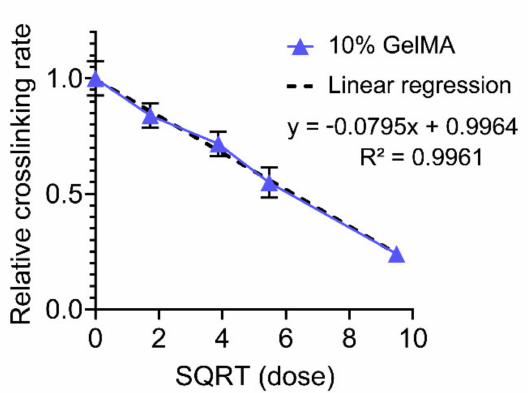
Figure 7. 10% GelMA crosslinking rate normalized to the control sample (no cefazolin) versus the square roots of cefazolin doses. Linear regression fit showing good agreement: R 2 =